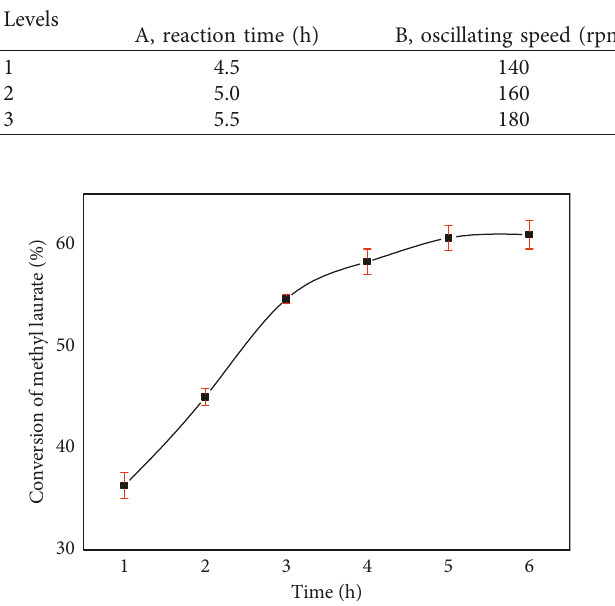
Figure 1: Effect of reaction time on lipase-catalyzed trans- esterification of decylglycerol with methyl laurate.